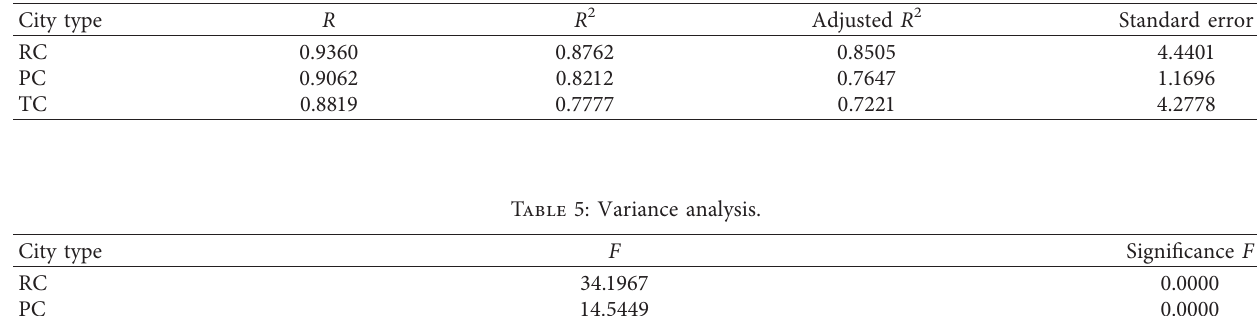
Table 4: Goodness-of-fit test results.